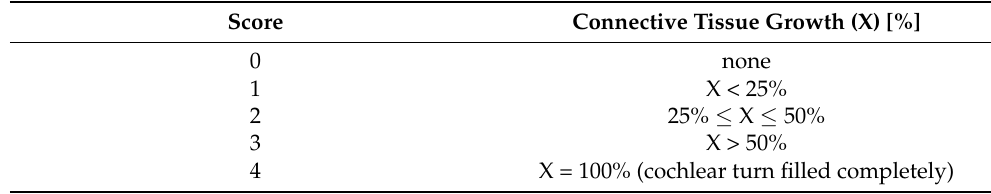
Table 2. Ranking score for connective tissue growth in the entire